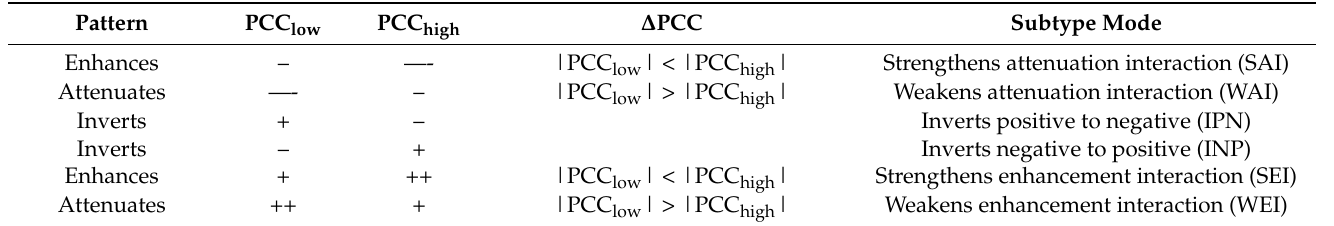
Table 2. Categories of TF-mediated RBP regulations on target